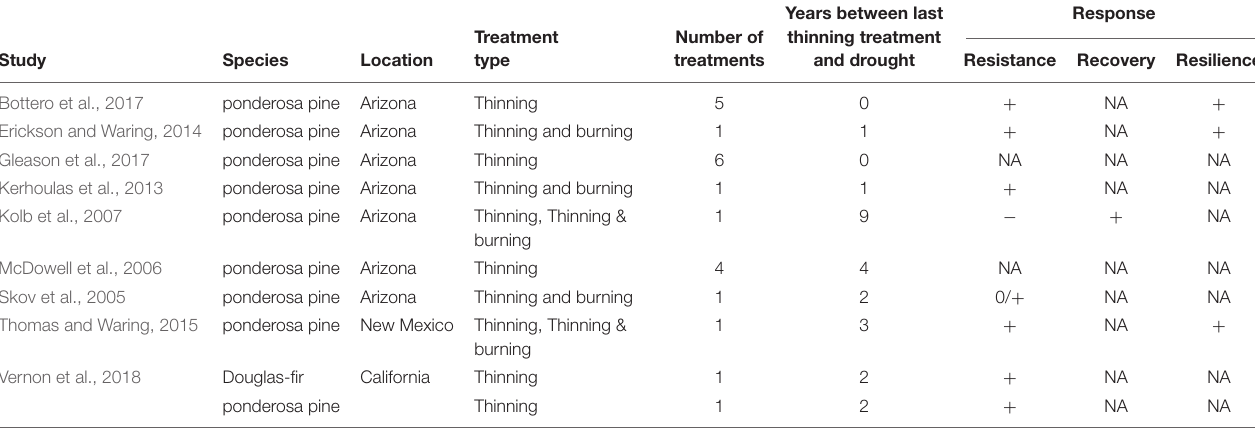
TABLE 1 | Studies using tree-ring evidence to assess thinning and prescribed burning effectiveness in moderating drought response in dry coniferous forests of the southwestern United